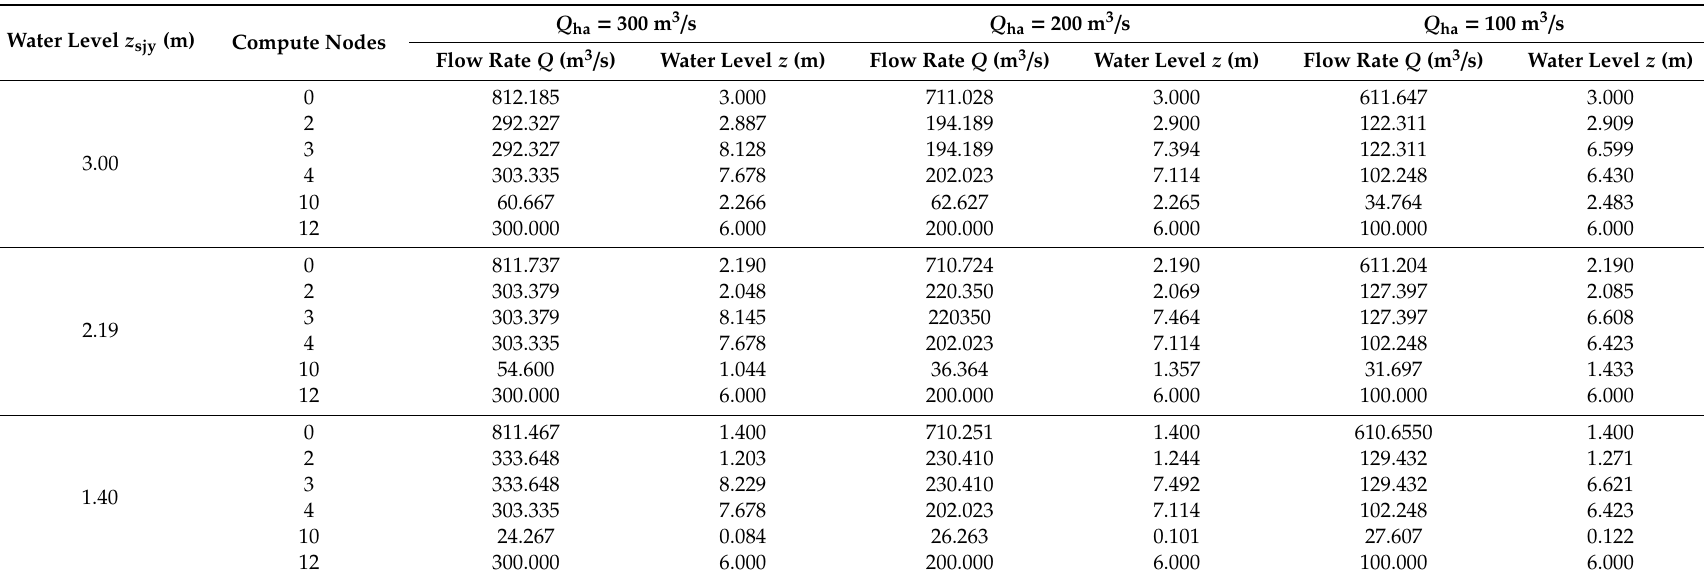
Table 5. Water level and flow rate of main compute nodes with optimal discharge ratio.